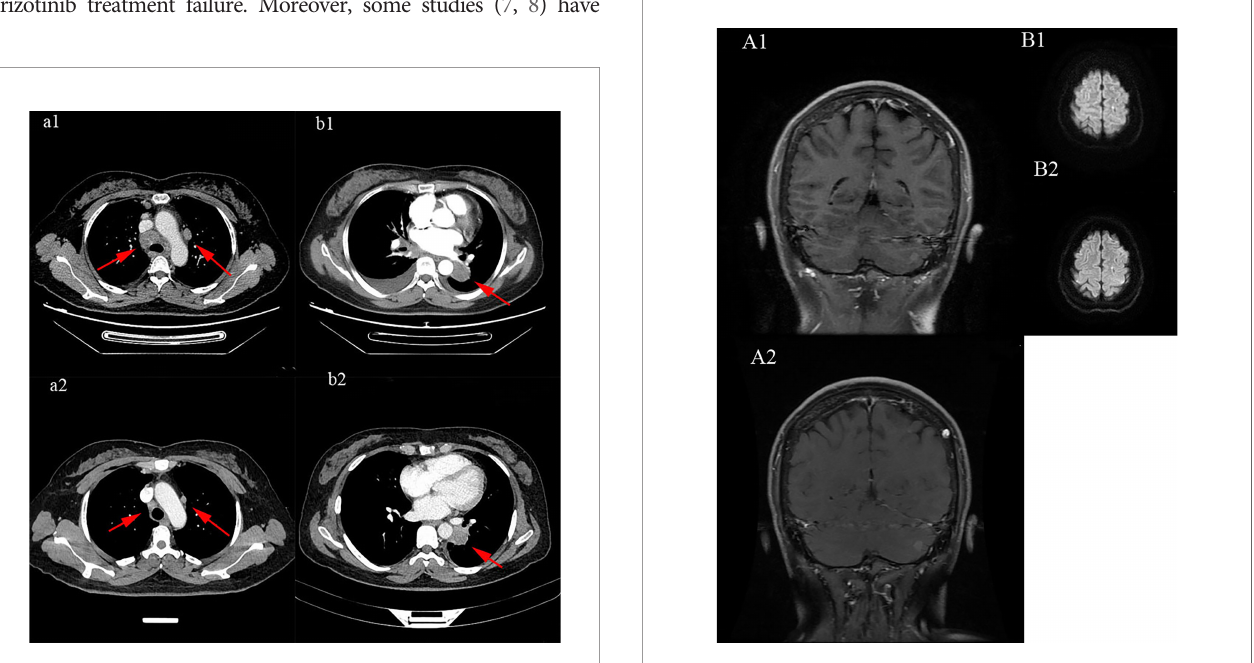
FIGURE 4 | The ef fi cacy was evaluated as partial response (PR): (a1, b1) were before treatment, (a2, b2) were after 2 cycles of